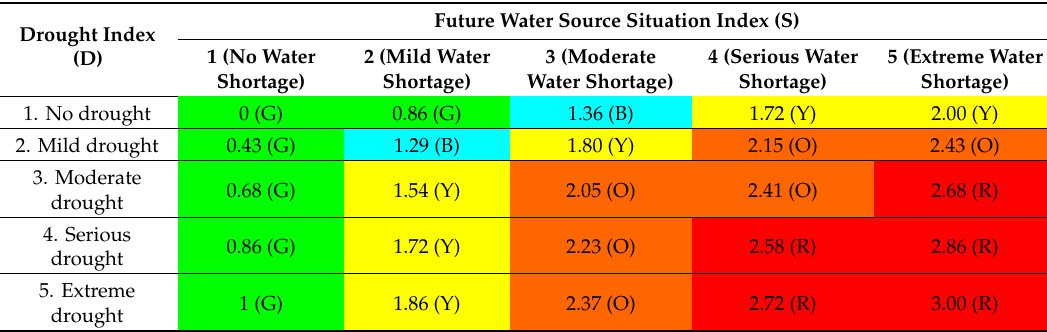
Table 4. Values of DAI and classification of early warning